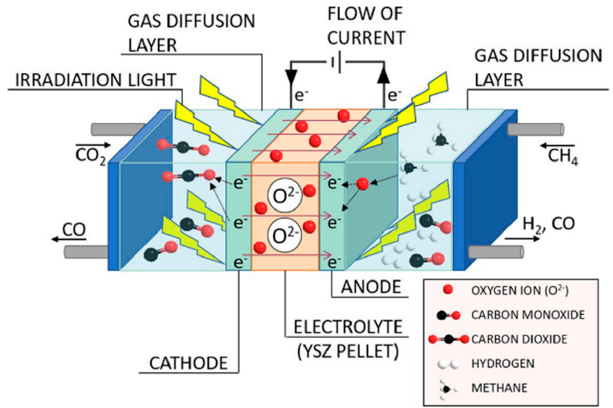
Figure 37. Gas-phase photoelectron chemical (GPEC) system. Reprinted from [52]. Copyright 2020 by John Wiley & Sons, Inc. YSZ: yttria-stabilized zirconia.